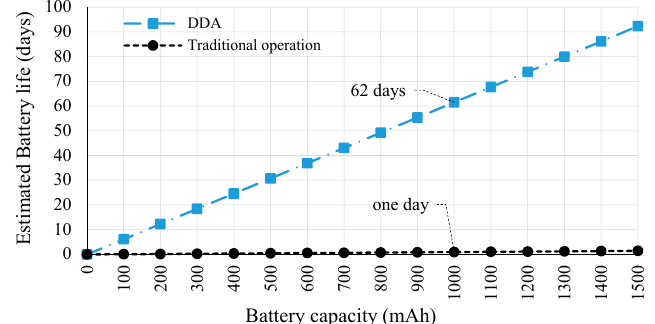
Figure 25. Battery capacity against estimated battery life for the FDS.